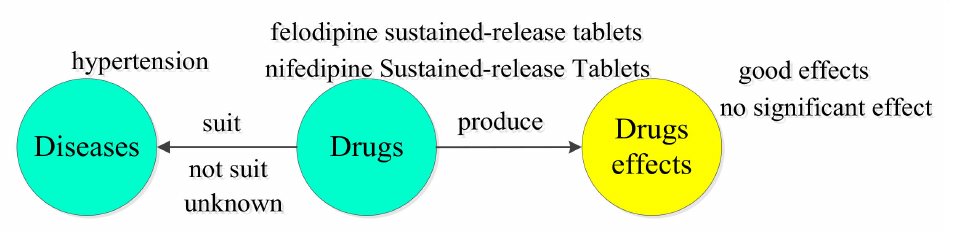
Figure 2. Diagram of the extracted